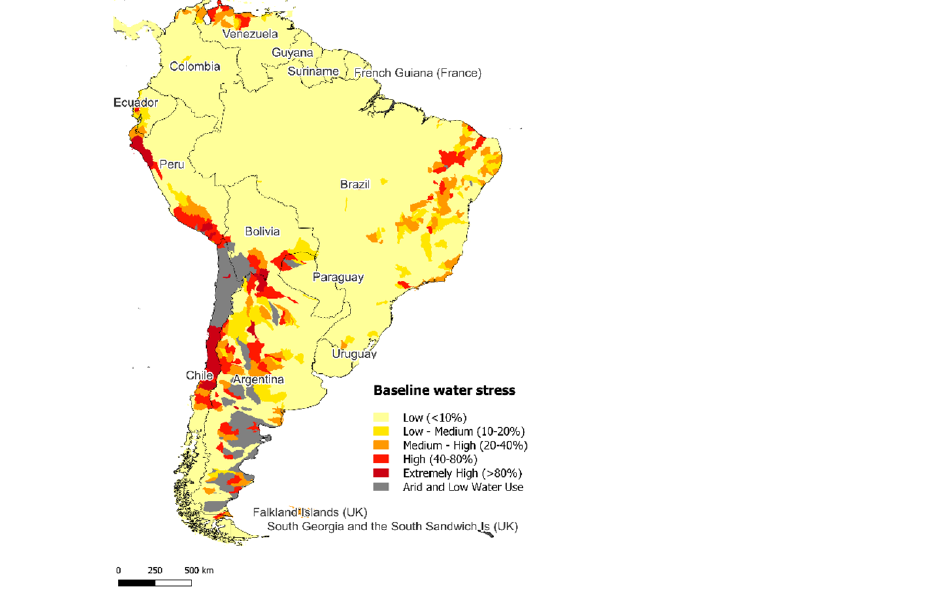
Figure 1. Baseline water stress on South America. Map data from Aqueduct Global Maps 2.1 Database [1].